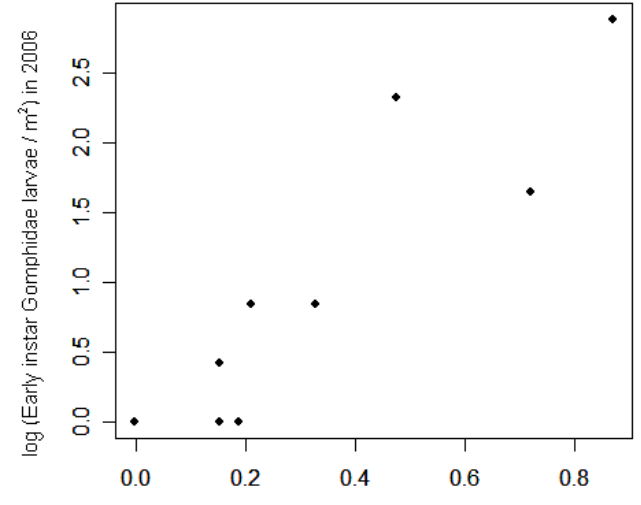
Figure 3. Larval densities of Gomphidae burrowers from nine north-temperate lakes graphed as a function of adult densities surveyed at the same sites in the previous